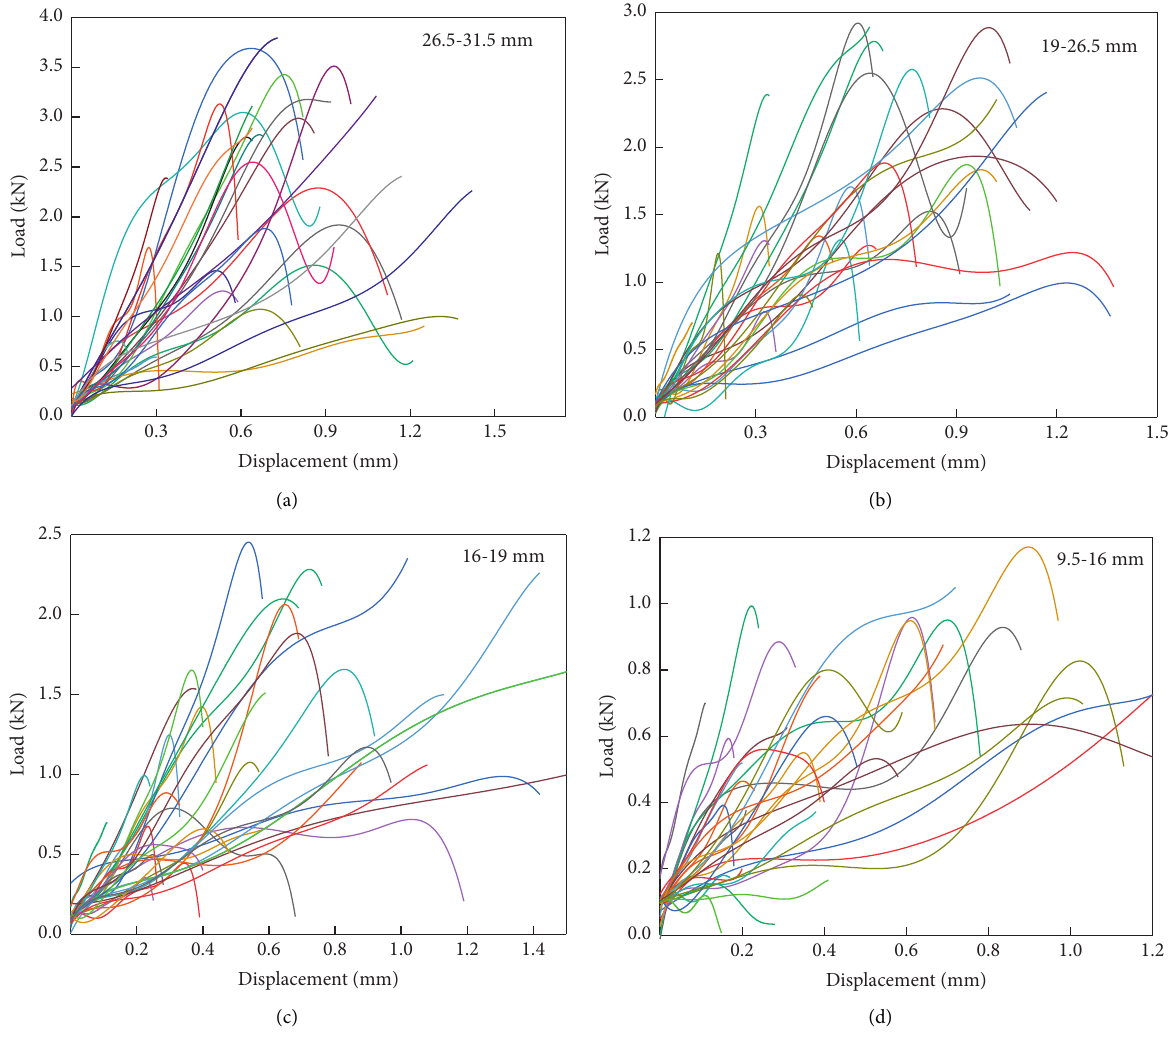
Figure 3: Load-displacement curve of recycled aggregate with different particle size. (a) 26.5–31.5mm. (b) 19–26.5mm. (c) 16–19mm. (d) 9–16